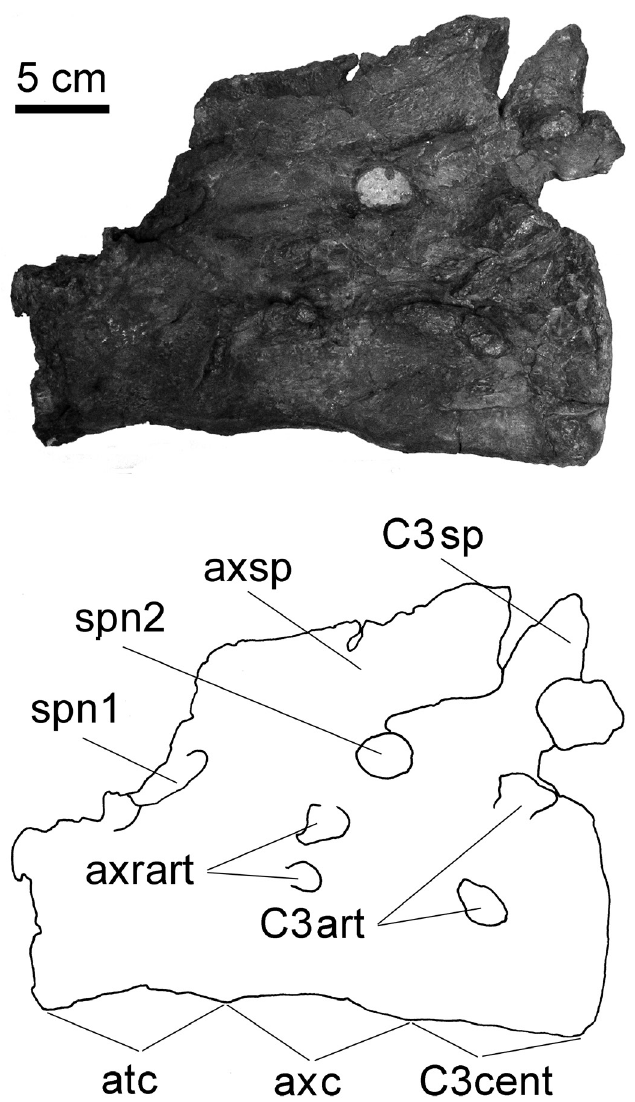
Figure 3. Syncervical in left lateral view. Vagaceratops irvinensis , CMN 41357.